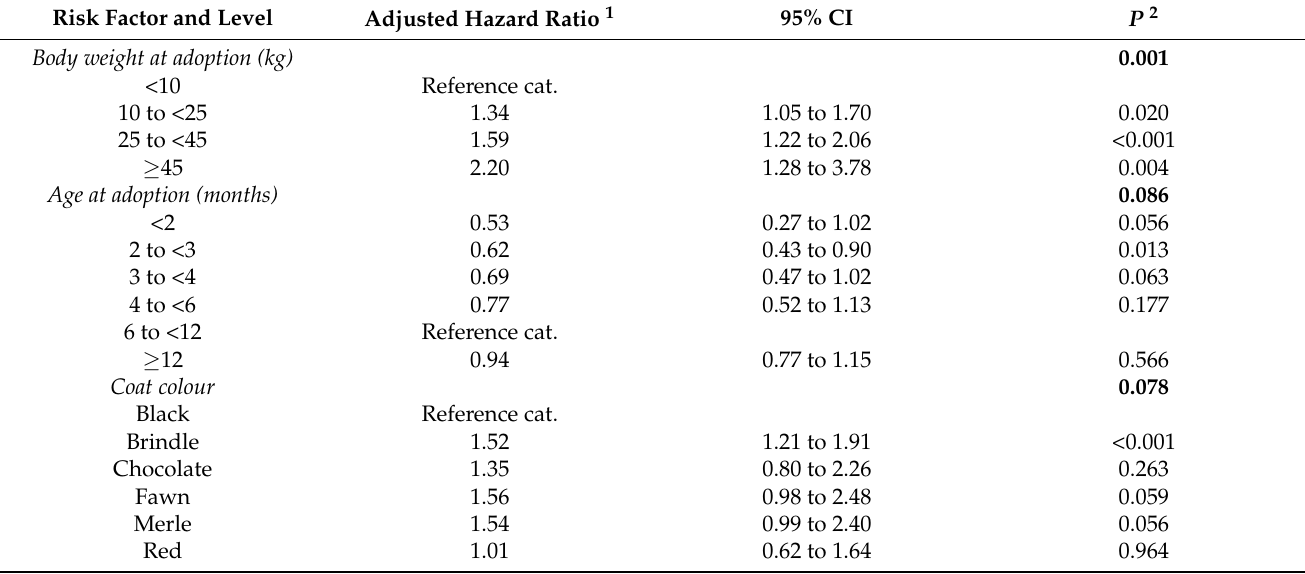
Table 3. Adjusted hazard ratio estimates for associations between putative risk factors and time to readmission to RSPCA Queensland for dogs adopted from RSPCA Queensland in 2019 and 2020. Bodyweight rather than breed was used in this